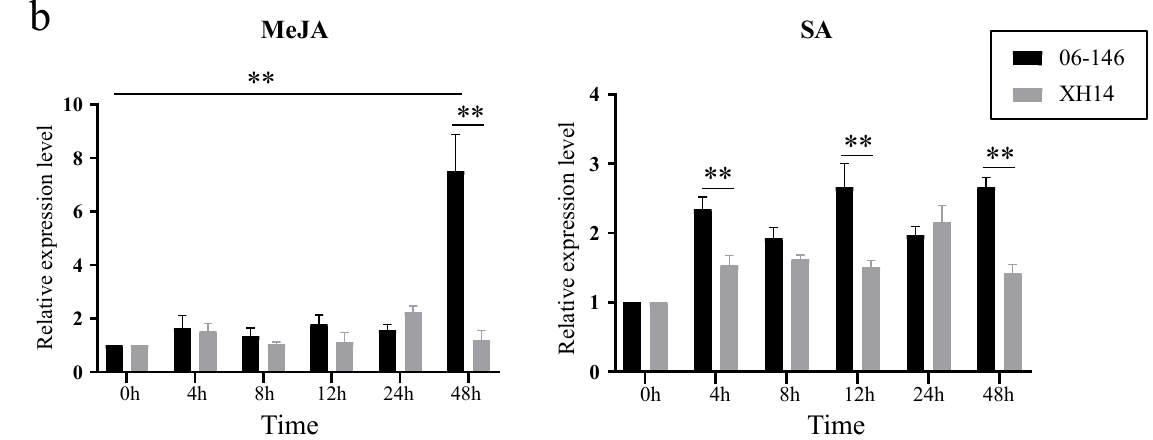
Figure 7. ( a ) Expression analysis of GbANR-47 in roots, stems and leaves of 06-146 and Xinhai 14 at 24 h and 0 h under FOV stress. ( b ) Expression analysis of GbANR-47 in leaves of 06-146 and Xinhai 14 treated with MeJA and SA at different time points. Error bars represent the average of three replicates ± SE. The difference from the control group is statistically significant, ** p < 0.01.